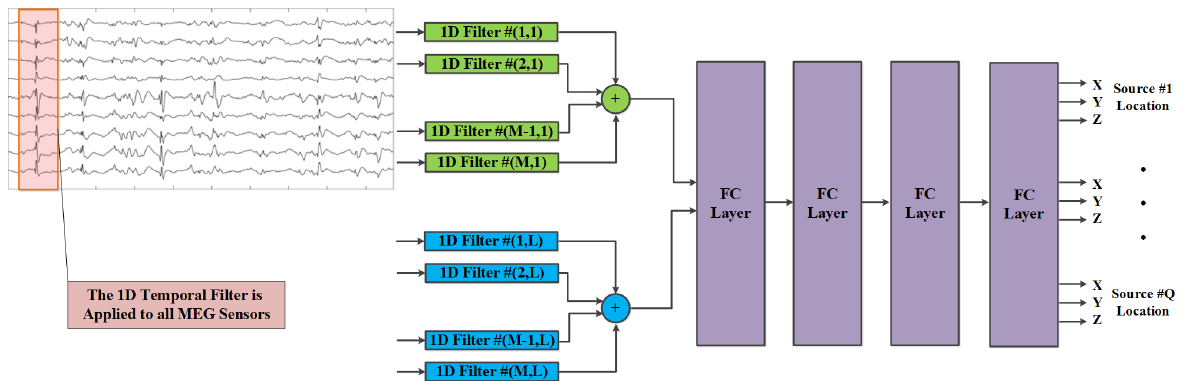
Figure 3. Illustration of the CNN-based MEG source localization solution. The end-to-end inversion operator performs mapping from the MEG time-series measurement space, using a bank of L space-time filters and four fully connected (FC) layers, to the source locations